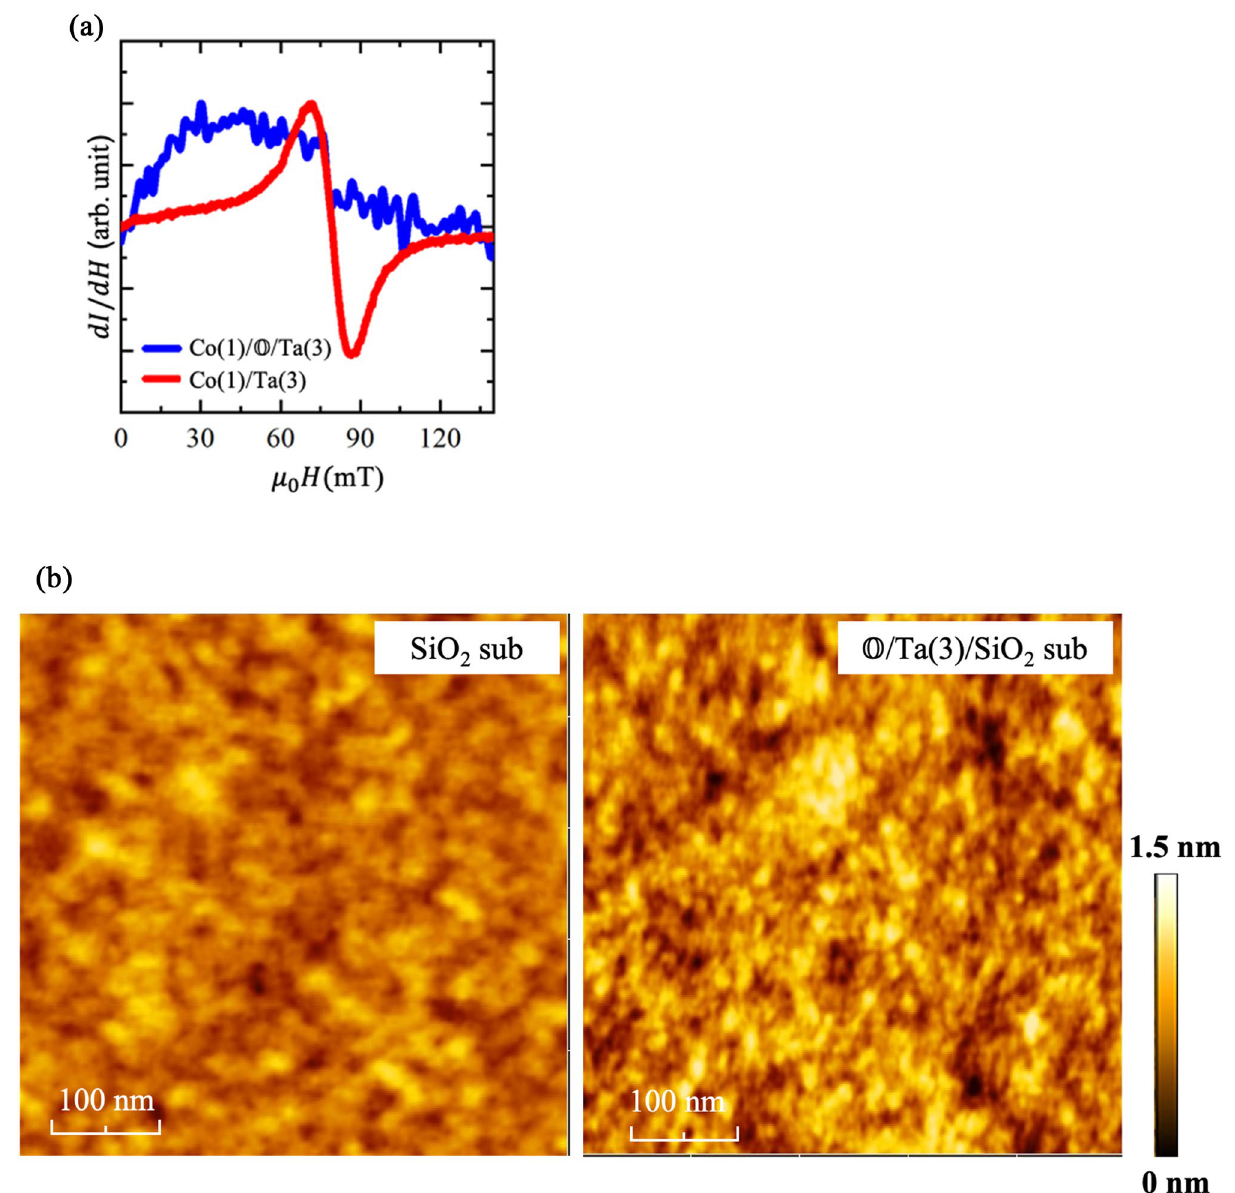
Figure 4. ( a ) Comparison of the FMR spectra of the Co (1 nm)/Ta (3 nm) and Co (1 nm)/ O /Ta (3 nm) samples. ( b ) Atomic force microscopic views of the surfaces of the SiO 2 substrate and the oxidized